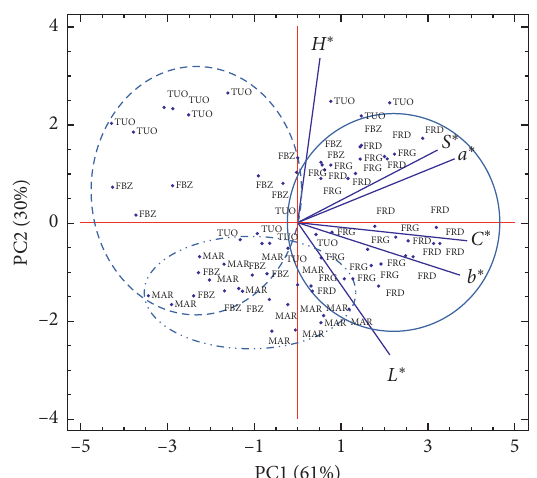
Figure 1: Principal component analysis (PCA) projections on PC1 and PC2. The eigenvalues are symbolized as blue segments rep- resenting traits that most affect each principal component. The 75 points plotted are cultivar mean values of each studied kernel color index: brightness index ( L ∗ ), redness index ( a ∗ ), yellowness index